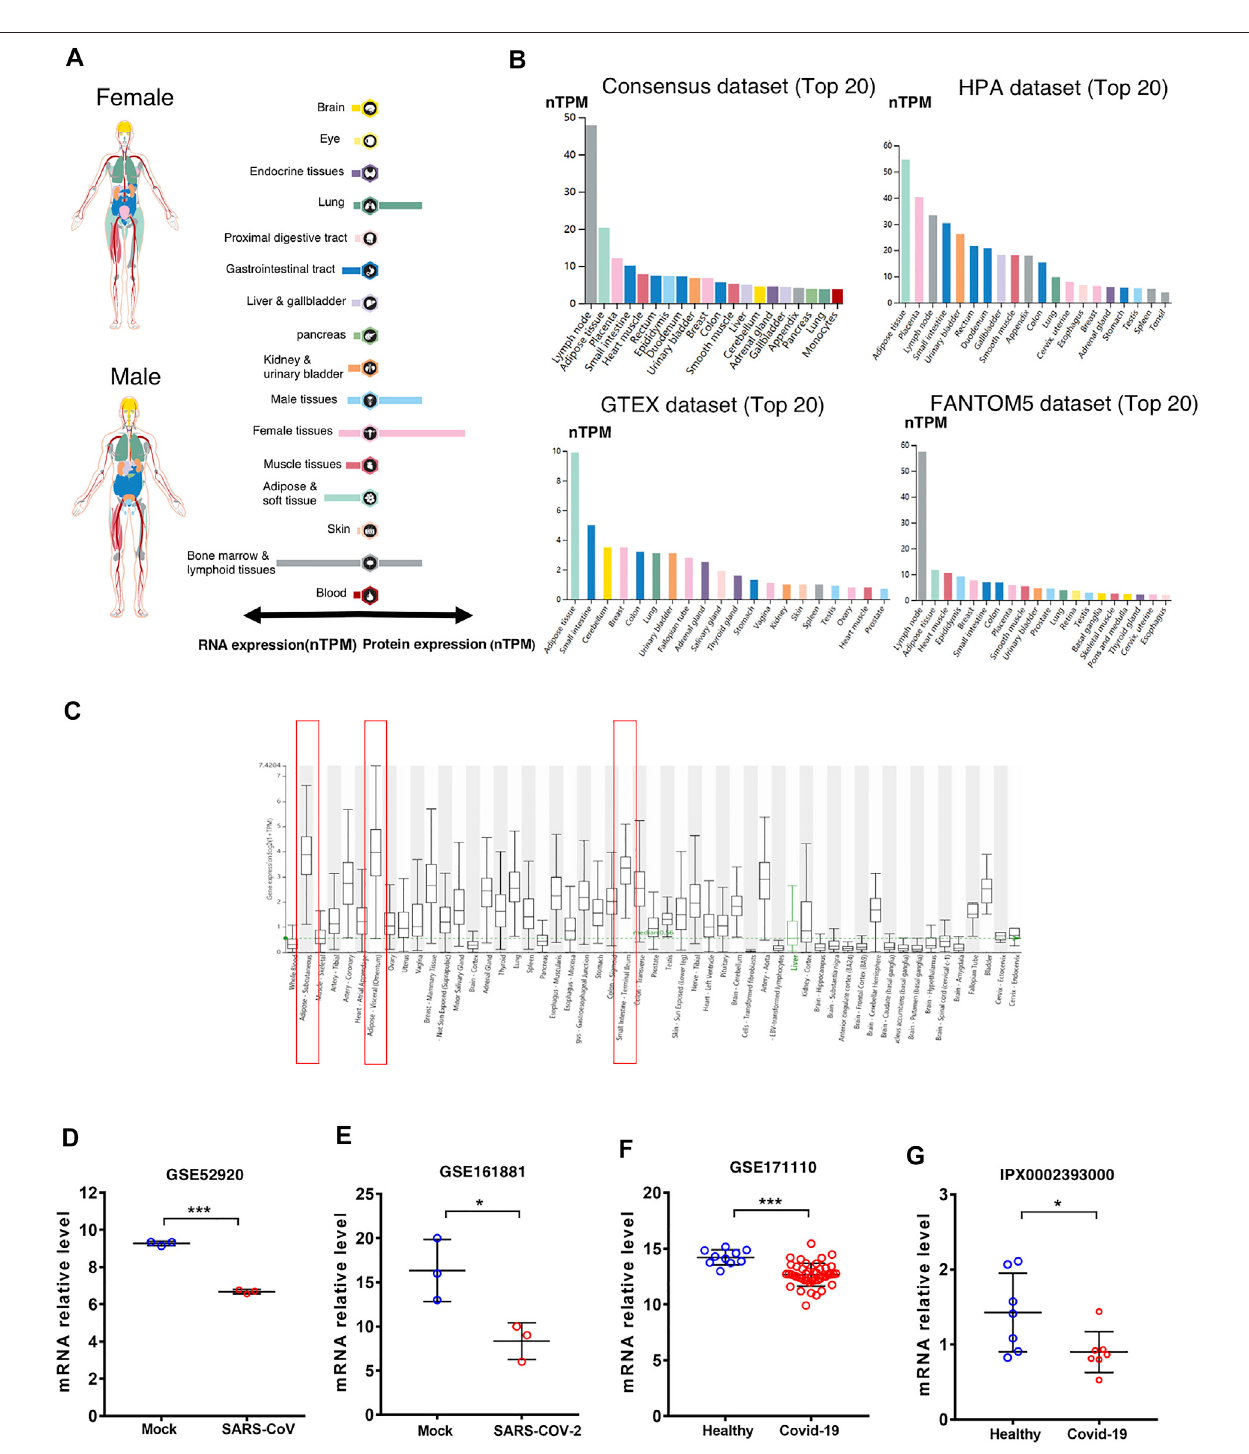
FIGURE 1 | Expression of CD209 in human tissues and organs. (A) mRNA and protein expression pro fi les of CD209 in all tissues and organs of healthy people analyzed in the Tissue Atlas database; RNA and protein expression summary shows the normalized expression (nTPM) values. Color-coding is based on tissuegroups. (B) Top20tissuesororganswithCD209mRNAexpressioninfourdatabases(Consensusdataset,Fantom5dataset,GTExdataset,andHPAdataset).Fourdatabase ’ s data are reported as nTPM (normalized protein-coding transcripts per million). Color-coding is based on tissue groups. (C) CD209 mRNA expression in various tissueswasanalyzedintheHCCDB database. (D) mRNAlevelofCD209inlungofmiceinfected withSARS-CoV ( n =6). (E) mRNAexpression levelofCD209inveroE6 cellslinetransfectedmock,SARS-CoV-2(moi=2)for8 h( n =6). (F) CD209levelsinperipheralbloodofCOVId-19patients( n =44)andtheirhealthycontrols( n =10). (G) CD209 expression in testis of COVID-19 patients ( n = 7) and their healthy controls ( n = 7). Data are represented as mean ± SD. * p < 0.05, *** p < 0.01, *** p < 0.001(Student ’ s t-test). Abbreviation: moi, multiplicity of infection; TPM, transcripts per million.